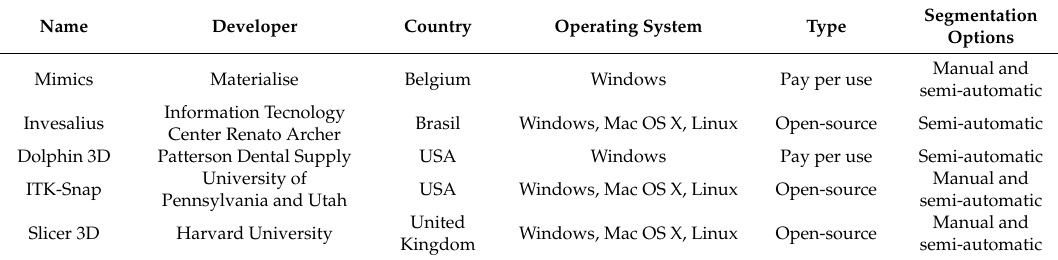
Table 1. Descriptive and general information of the software tested in the present study.